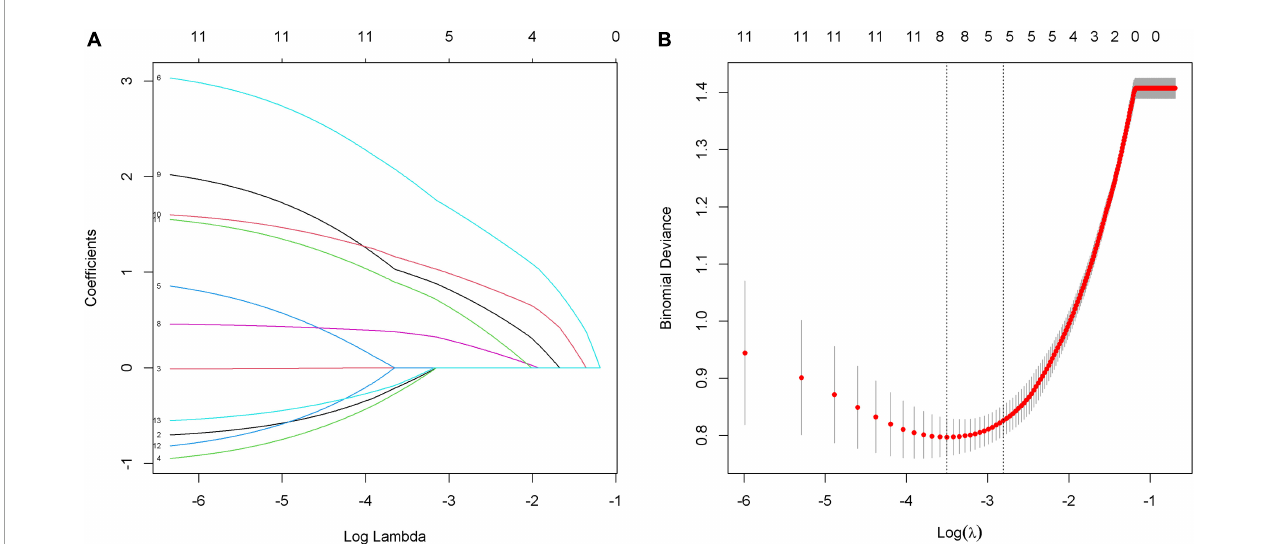
FIGURE3 Predictors selection by using the least absolute shrinkage and selection operator (LASSO) model. (A) LASSO coefficient profiles of 11 alternative factors. Each curve represents a factor. Since PAV is a triadic variable, it was divided into three variables when analyzed in R language software. As a result, there are thirteen curves shown in the figure. (B) Tuning parameter ( λ ) selection in the LASSO model using 10-fold cross-validation via minimum criteria. The red dots in the figure indicate the binomial deviance corresponding to each lambda. The two dashed lines represent two special lambda values, min and 1 s, respectively. The 1 s corresponds to the optimal lambda value of a model with excellent performance and the smallest number of independent variables. Finally, combined with figure (A) , five factors (GCS, FzMMNA, EEG background activity, EEG-R, and sleep spindles) were selected into the following binary logistic regression analysis.